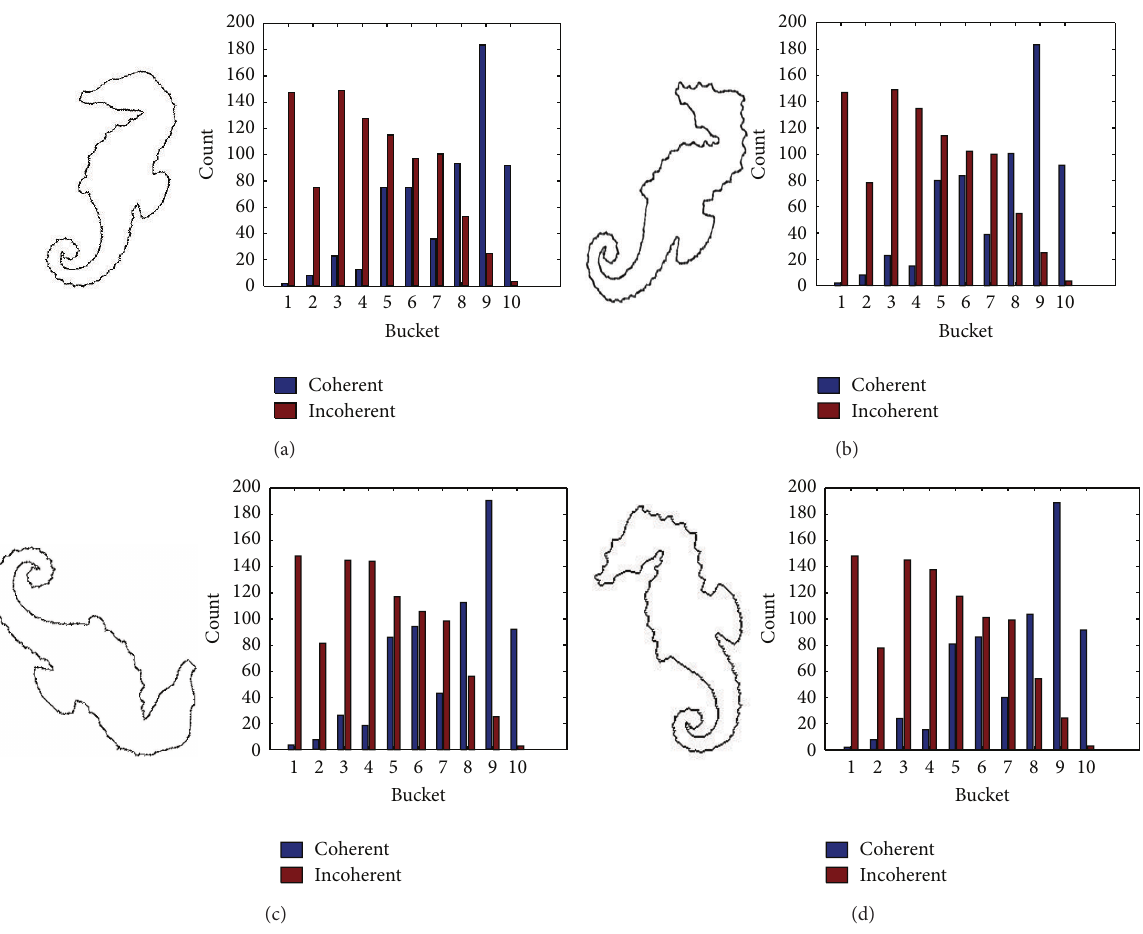
Figure 8: The MDCV histogram of Hippocampus images after rotation in different angles; (a) clockwise rotation through 20 degrees; (b) clockwise rotation through 60 degrees; (c) clockwise rotation through 120 degrees; (d) clockwise rotation with 330 degrees.